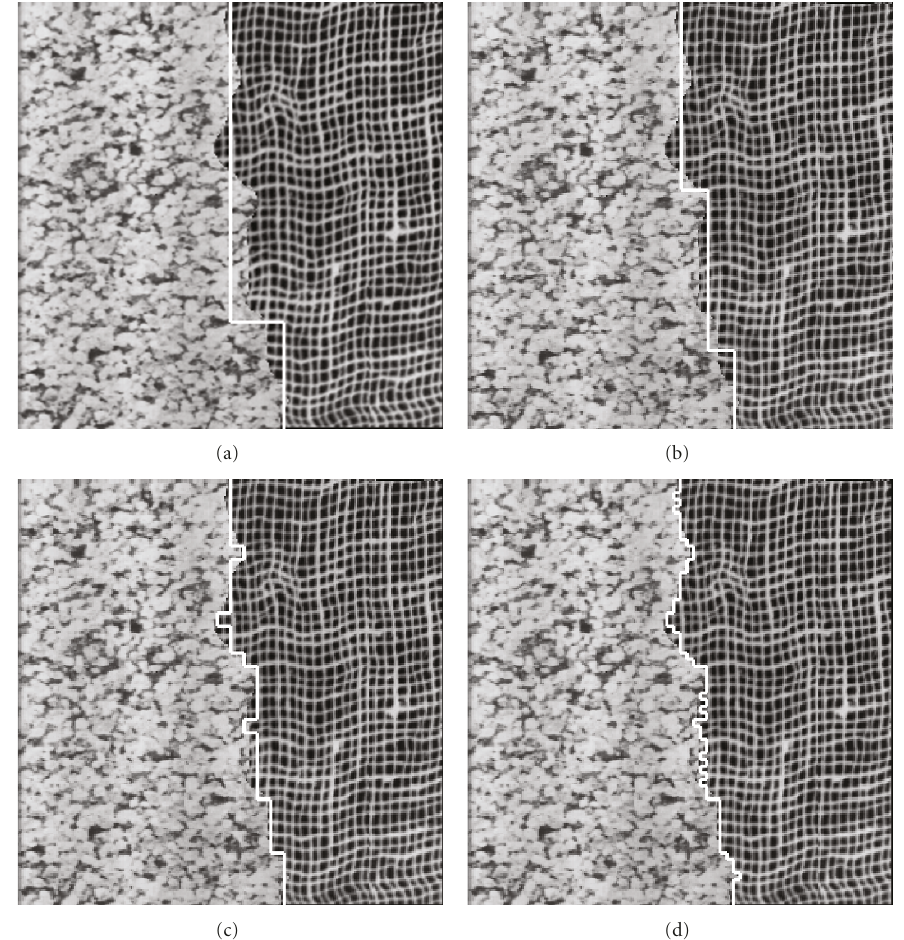
Figure 5: Segmentation results of Image II at 3 di ff erent resolution levels.